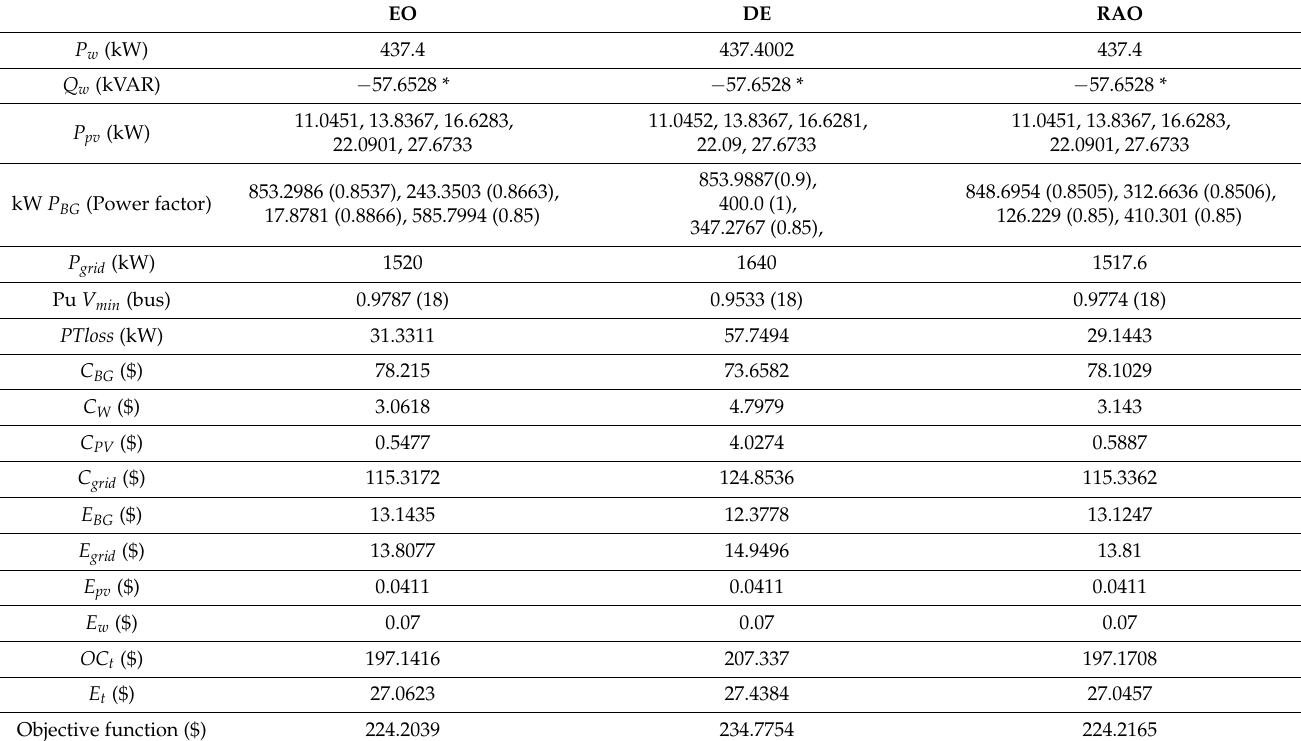
Table 3. Optimal operation of MG at hour 12 using EO, DE, and RAO